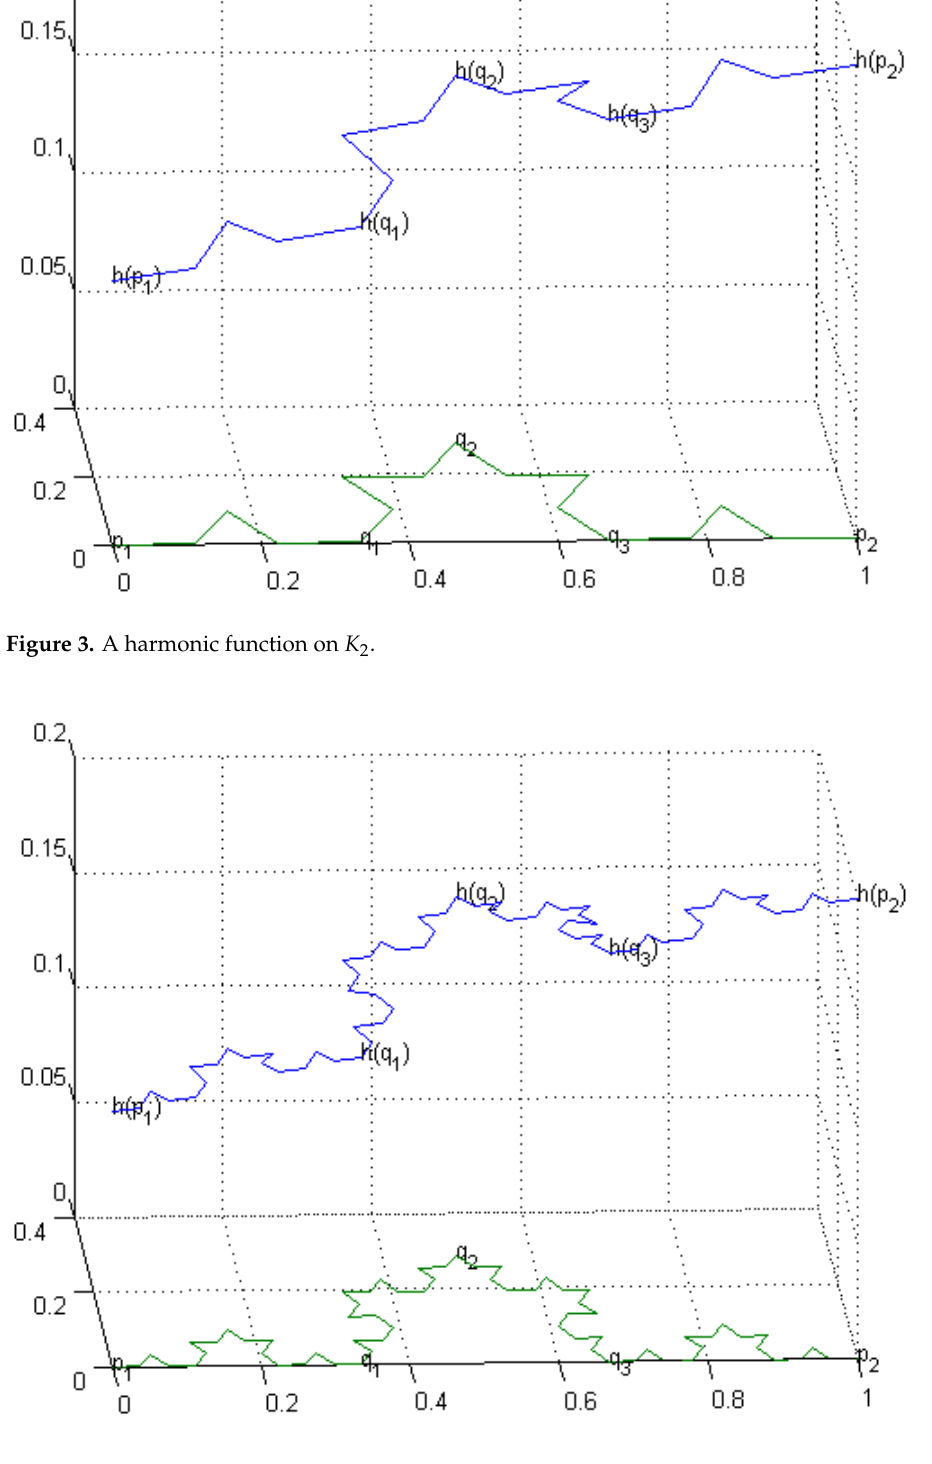
Figure 4. A harmonic function on K 3